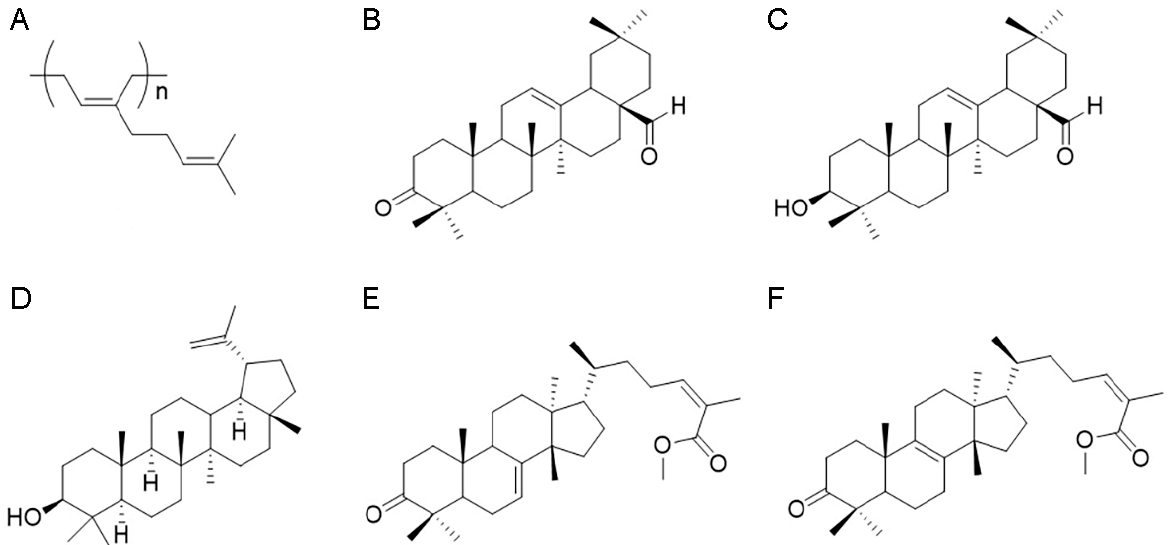
Figure 1. Phytochemical characterization of Pistacia lentiscus L. resin. Chemical structures of 1,4- poly- β -myrcene ( A ), keto-oleanolic aldehyde ( B ), oleanolic aldehyde ( C ), lupeol ( D ), 24Z-mastica- dienonic acid methyl ester ( E ), and 24Z-isomasticadienonic acid methyl ester ( F